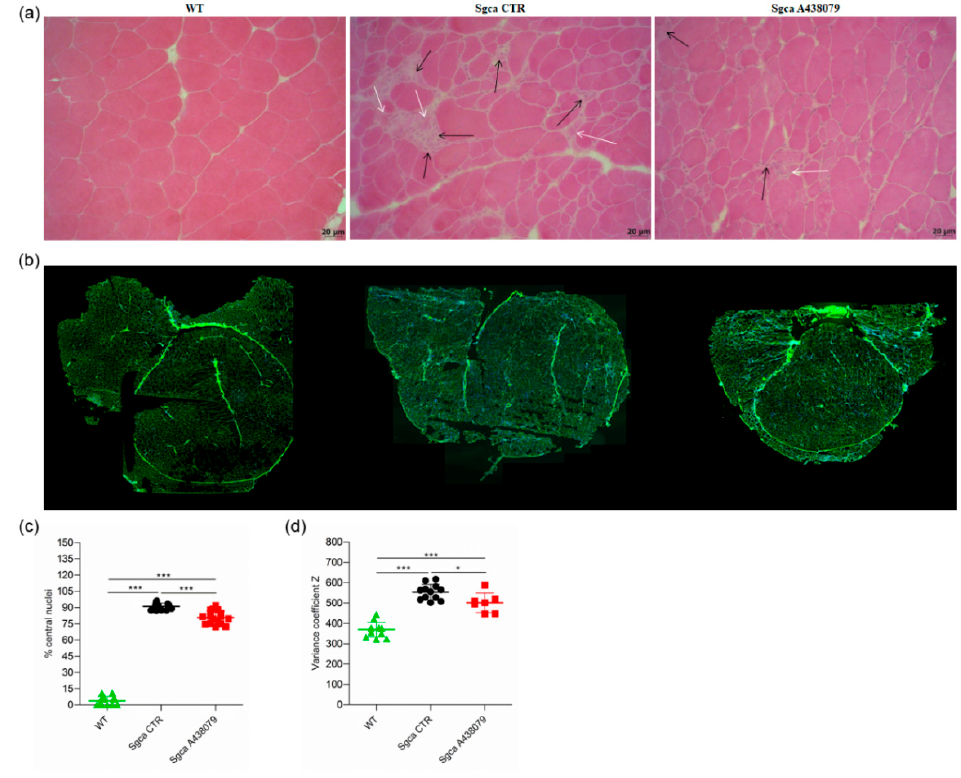
Figure 2. A438079 ameliorates the muscle morphology of Sgca mice. ( a ): frozen quadriceps tissue sections from WT, Sgca CTR and Sgca A438079 mice were collected at the end of the twenty-fourth week of treatment and stained with standard H&E technique. A representative image is shown. Black arrows indicate inflammatory infiltrates, white arrows indicate degenerating muscle fibers. Final magnification, 20 × ; ( b ): frozen quadriceps tissue sections from WT, Sgca CTR and Sgca A438079 mice were collected at the end of the twenty-fourth week of treatment and stained with wheat germ agglutinin (WGA) and DAPI. The whole quadricep section has been re-constructed; ( c ): percentage of central nuclei was quantified in four consecutive fields for each muscle section stained with wheat germ agglutinin (WGA) and DAPI and normalized for the fiber number of each field (WT n = 4; Sgca CTR n = 4; Sgca A438079 n = 4); ( d ): muscle fiber diameter variability from WT, Sgca CTR and Sgca A438079 mice was calculated in the whole area as variance coefficient Z of minimal Feret’s diameter (WT n = 12; Sgca CTR n = 12; Sgca A438079 n = 7). In panels ( c , d ), data are expressed as mean ± SD. Statistical analysis was performed by one-way ANOVA followed by Tukey’s multiple comparison test. Asterisks indicate statistical significance (*, p < 0.05; ***, p <